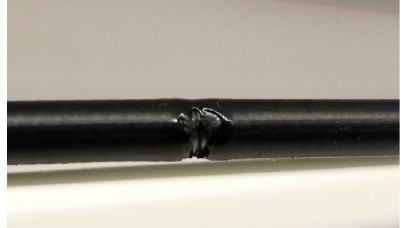
Figure 7. Laser cutting test results for the laminated spiral without inner tube.